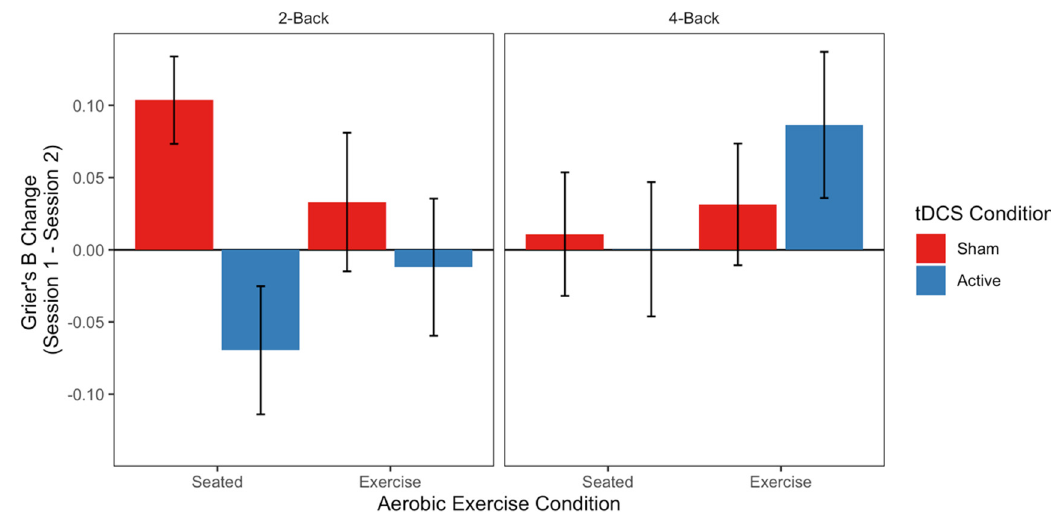
Figure 4. Bias to respond “Target” (Grier’s β ) on the n-back task. Bars depict average differences between Sessions 1 and 2 for each Aerobic Exercise Condition (Seated vs. Exercise, leftmost and rightmost bars of each panel, respectively) and tDCS Condition (Active vs. Sham, in Blue and Red, respectively).